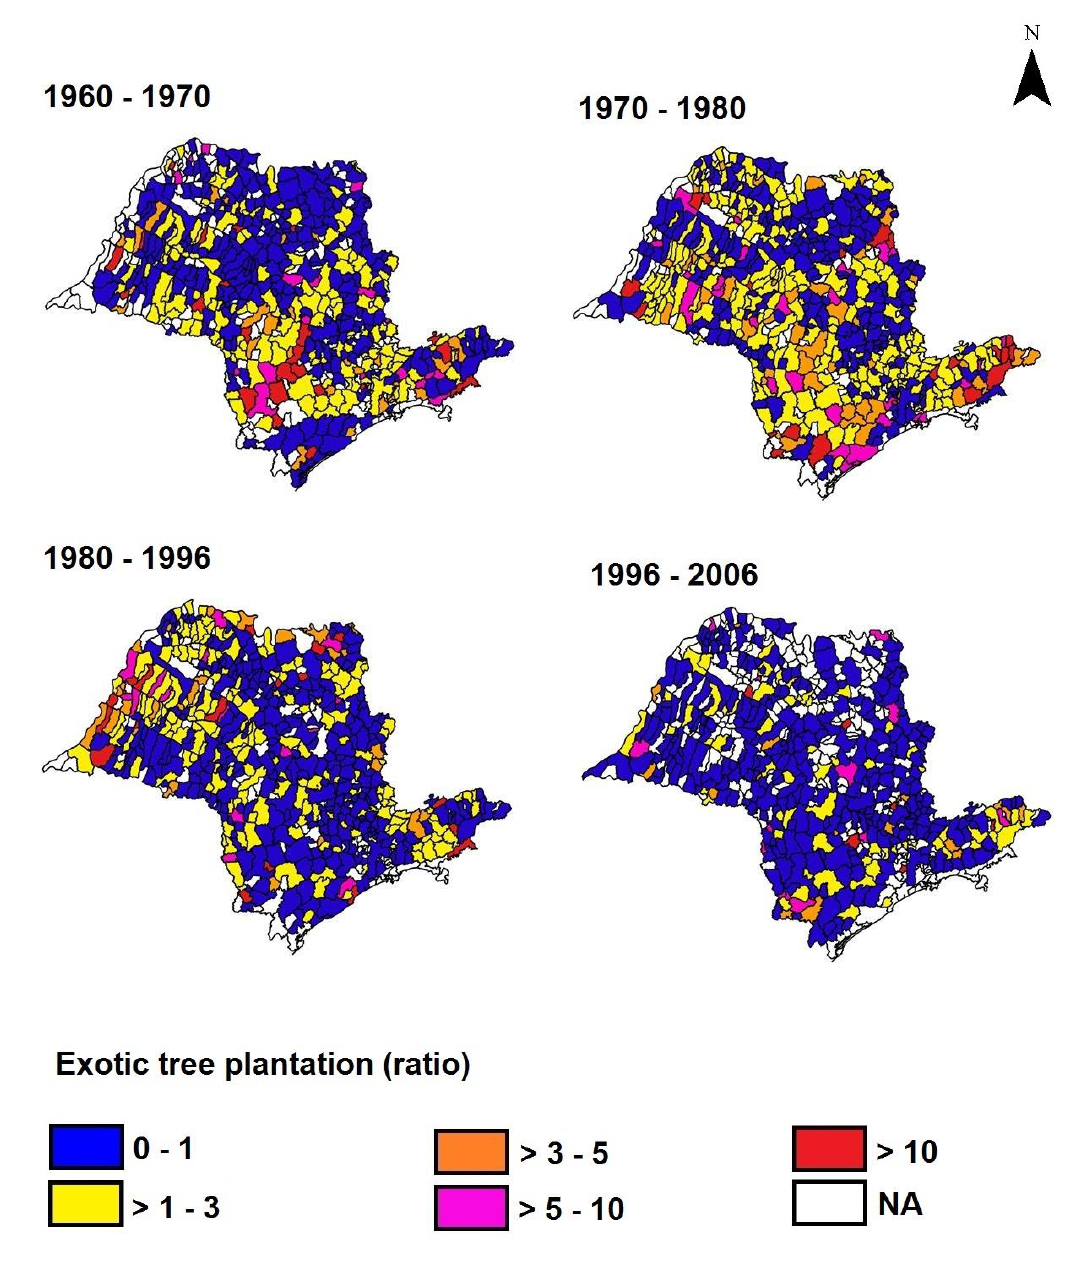
FIGURE A1.8 Exotic tree plantation ratio at the municipality-scale for São Paulo state calculated for the intervals 1960-1970, 1970-1980, 1980-1996 and 1996-2006. Exotic tree plantation ratio was calculated by dividing the percentage of exotic tree plantation in one census by the percentage of exotic tree plantation in the previous census (e.g. values in 1970 / values in 1960). Ratio values greater than 1 (one) indicate that exotic tree plantation increased over the census interval and values lower than 1 (one) indicate that it decreased. Municipality boundaries are shown in black. (NA) Missing